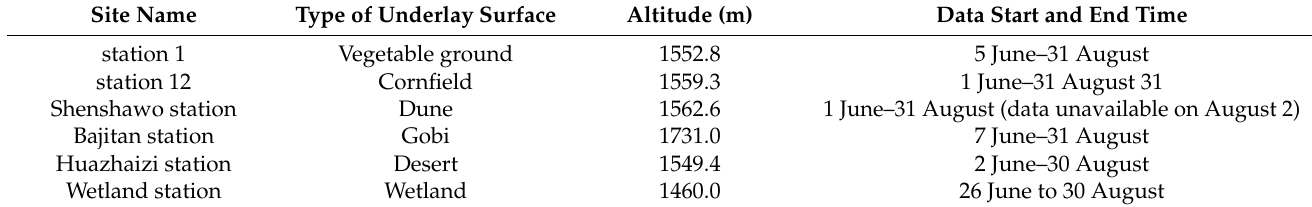
Table 1. Site name and related information of the research area.